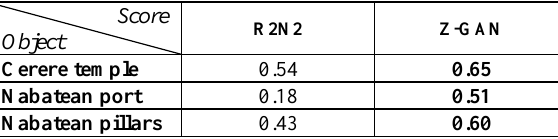
Table 1: Expert score for the Cerere temple and two objects from the crowdsourcing